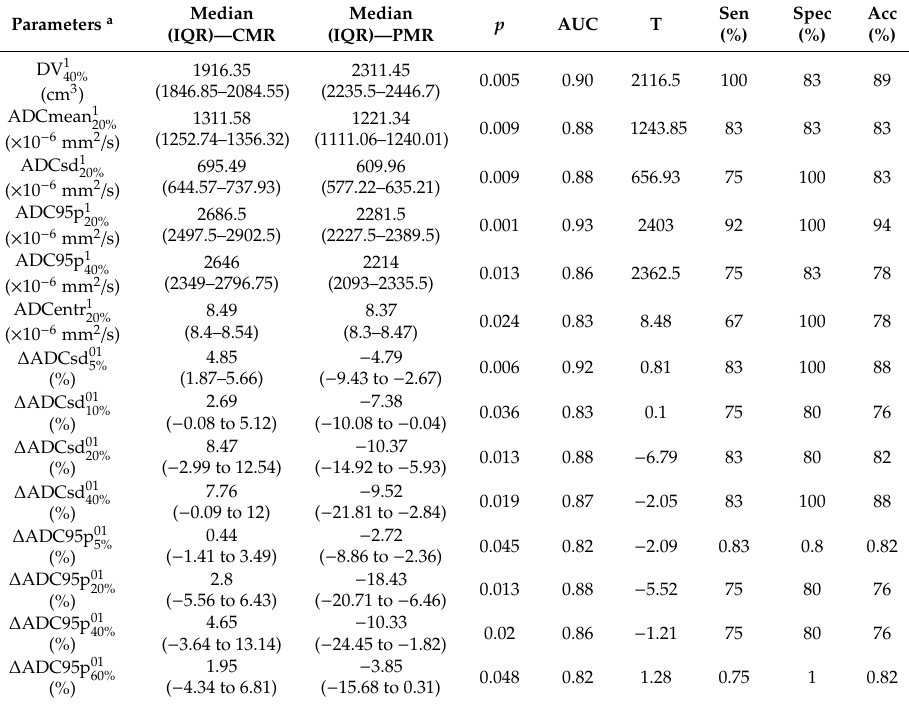
Table 5. Significant results for assessment of interim response to